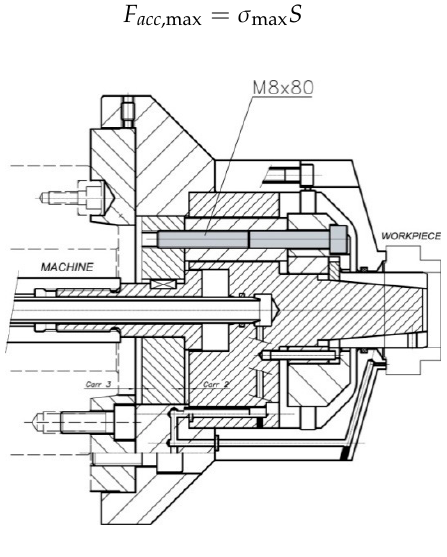
Figure 5. Components subjected to the maximum tensile stress.